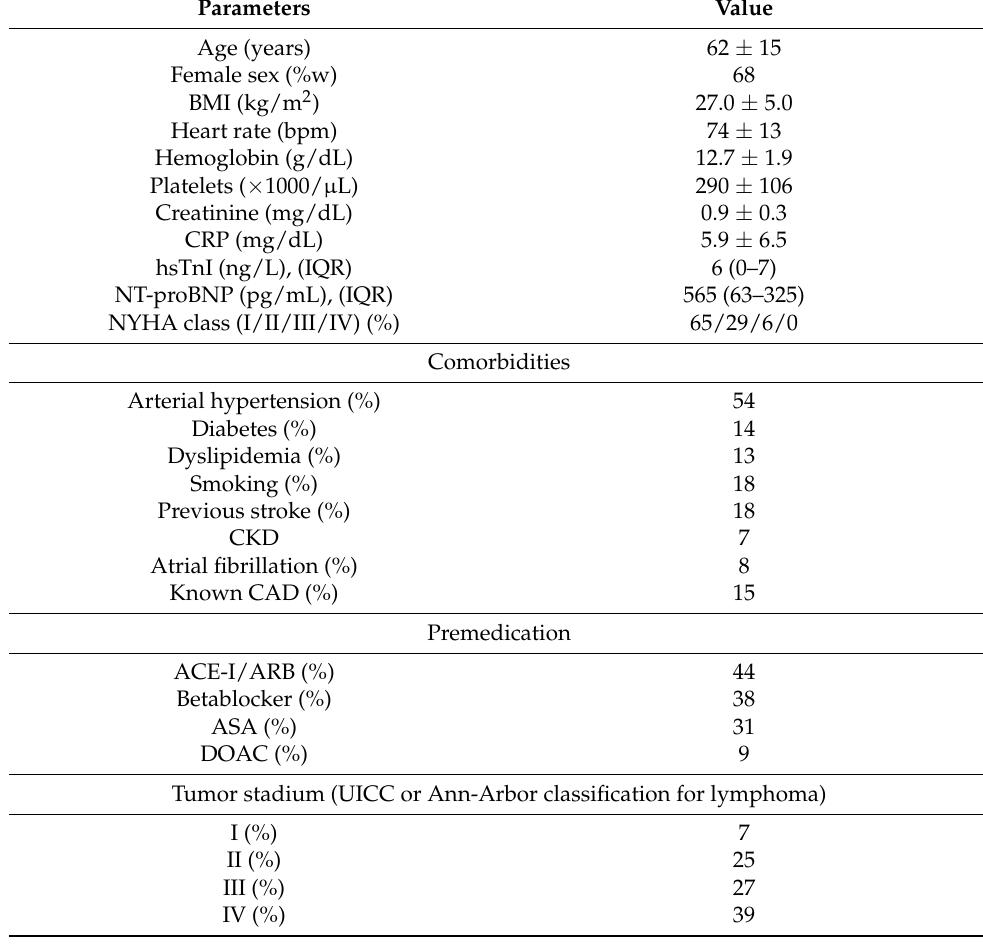
Table 1. Baseline